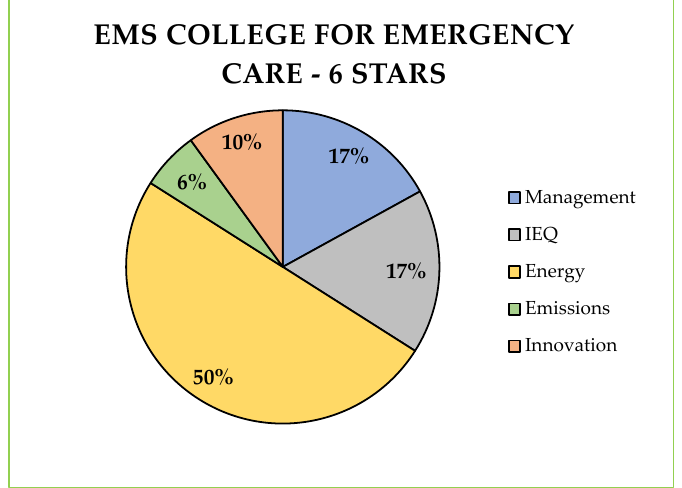
Figure 8. Percentage of credit details for 6-star rating.